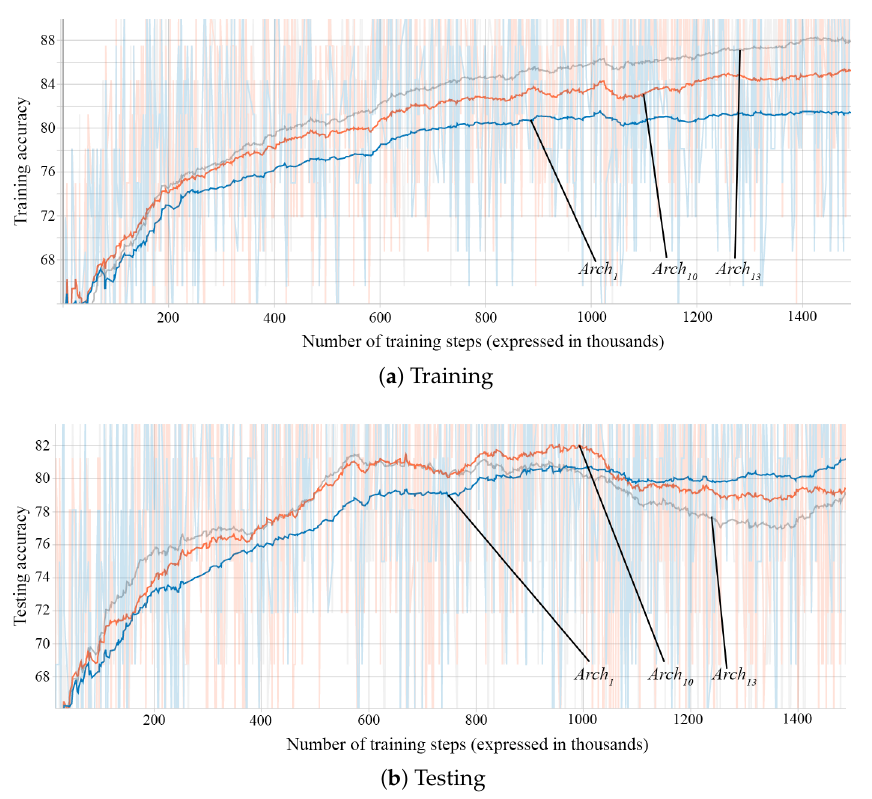
Figure 10. Accuracies according to the number of hidden layers: Arch 1 —1 (blue), Arch 10 —2 (orange), and Arch 13 —3 (gray); ( a ) training accuracies and ( b ) testing accuracies.